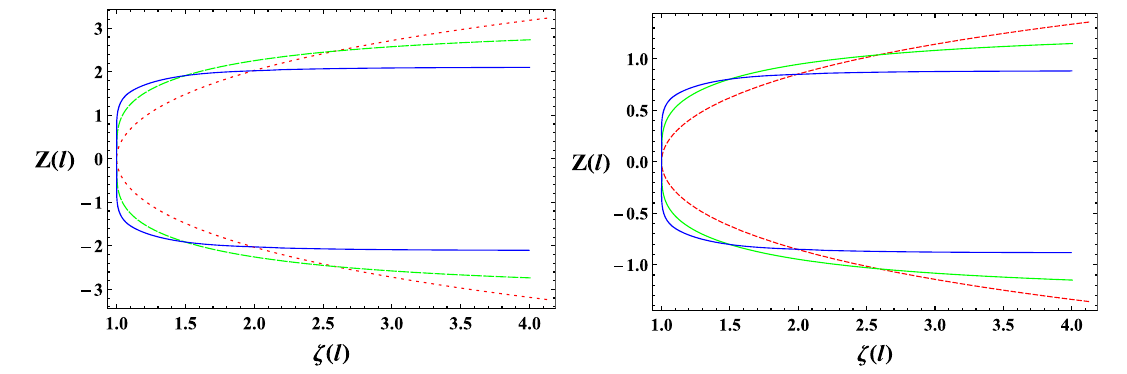
Fig. 3 Embedding diagrams of 5D-WGEB wormhole with growing (left) and decaying (right) warp-factor for m = 2 , 4 , 8 represented by the dotted, dashed and continuous curves, respectively